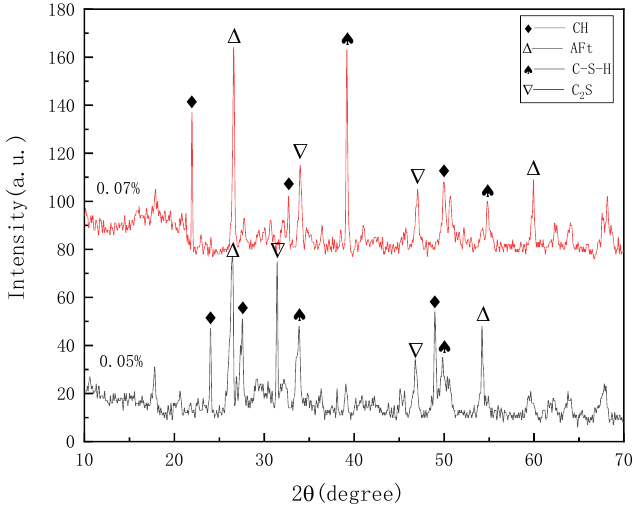
Figure 12. XRD patterns of cement-based composites with different GO content.